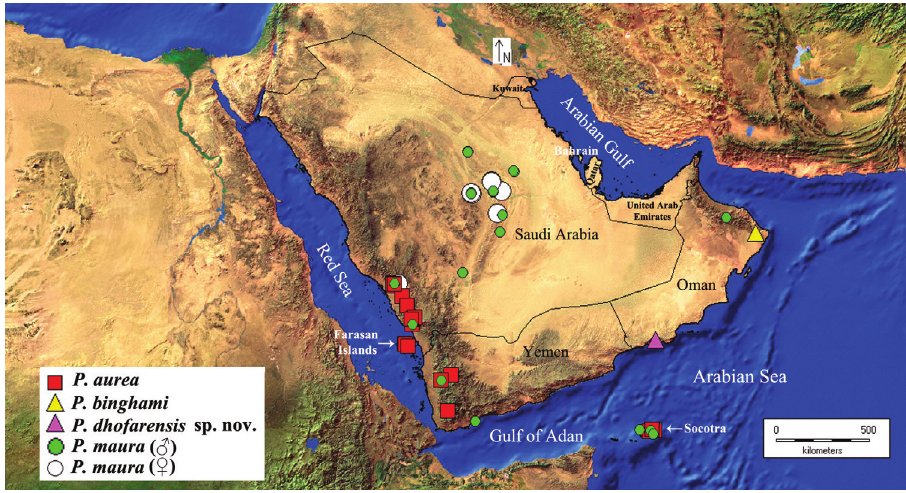
Figure 1. Distribution map of P. aurea (Klug), P . binghami Bischoff, P . dhofarensis sp. nov., and P. maura Bischoff in the Arabian Peninsula.